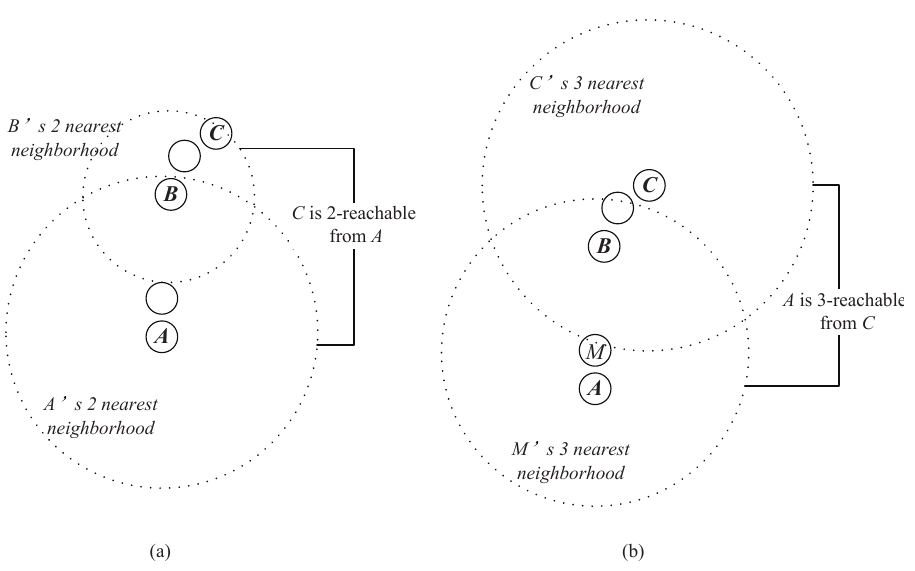
Figure 6. ( a ) The required neighbor’s number from A to C is 2. ( b ) The required neighbor’s number from C to A is